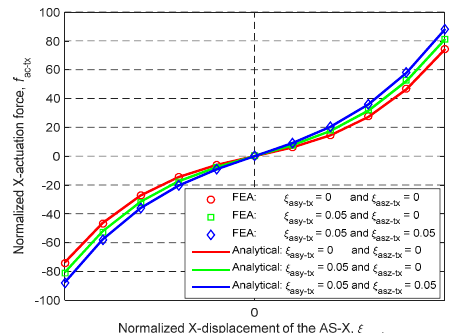
Figure 11. Analytical result and FEA result comparison regarding the relationship between the normalized X ms -axis primary translation of the AS-X and the normalized X ms -axis actuation force under the different conditions.